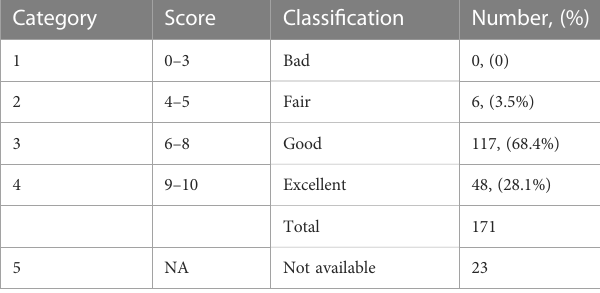
TABLE 7 Cosmetic scores for surgeries in breast cancer